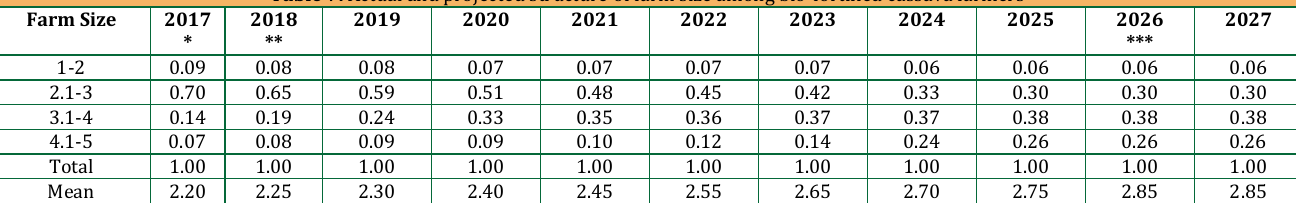
Table 7: Actual and projected structure of farm size among bio-fortified cassava farmers Farm Size